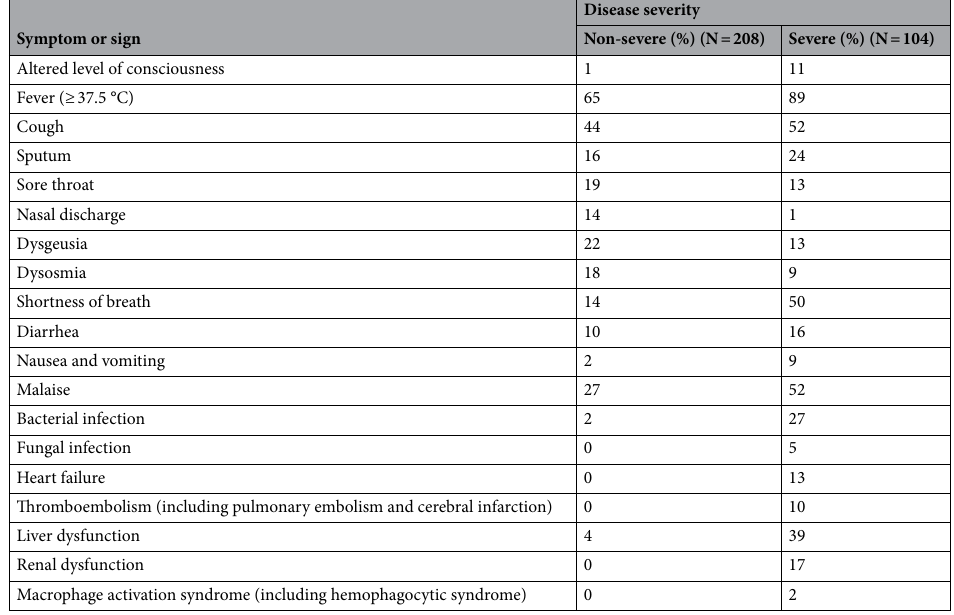
Table 1. Clinical symptoms and signs according to disease severity (N =